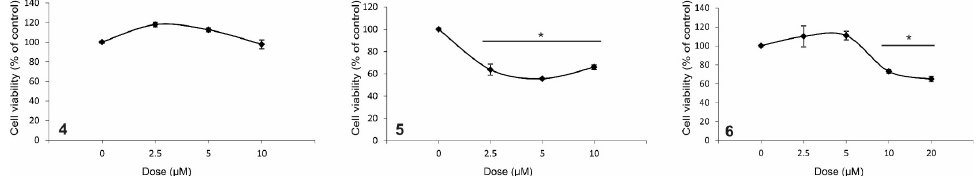
Figure 3. The effect of compounds 4 − 6 on the viability of peritoneal exudate cells. Peritoneal exudate cells were treated with 4 − 6 and subjected to CV viability assay after 72 h. The data are expressed as percentage of viability of untreated control (set as 100%) from one representative out of three independent experiments and presented as mean ± SD of triplicate cultures (* p < 0.05 in comparison to untreated cells).